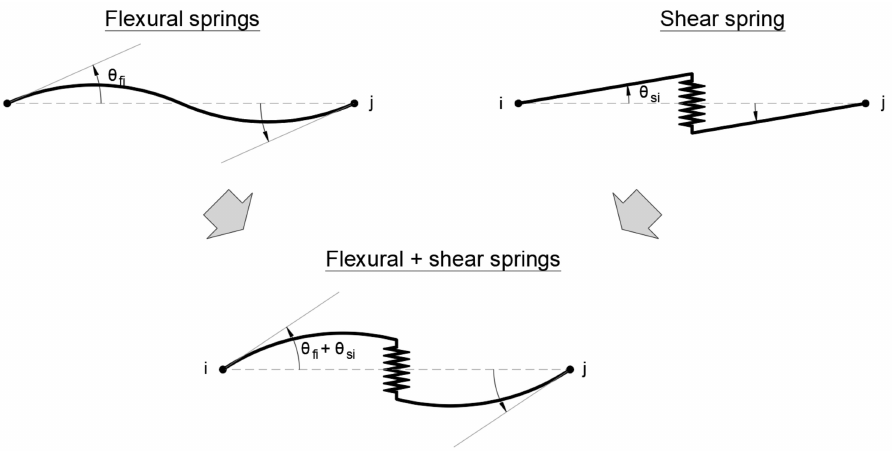
Figure 6. Beam model with nonlinear flexural and shear springs